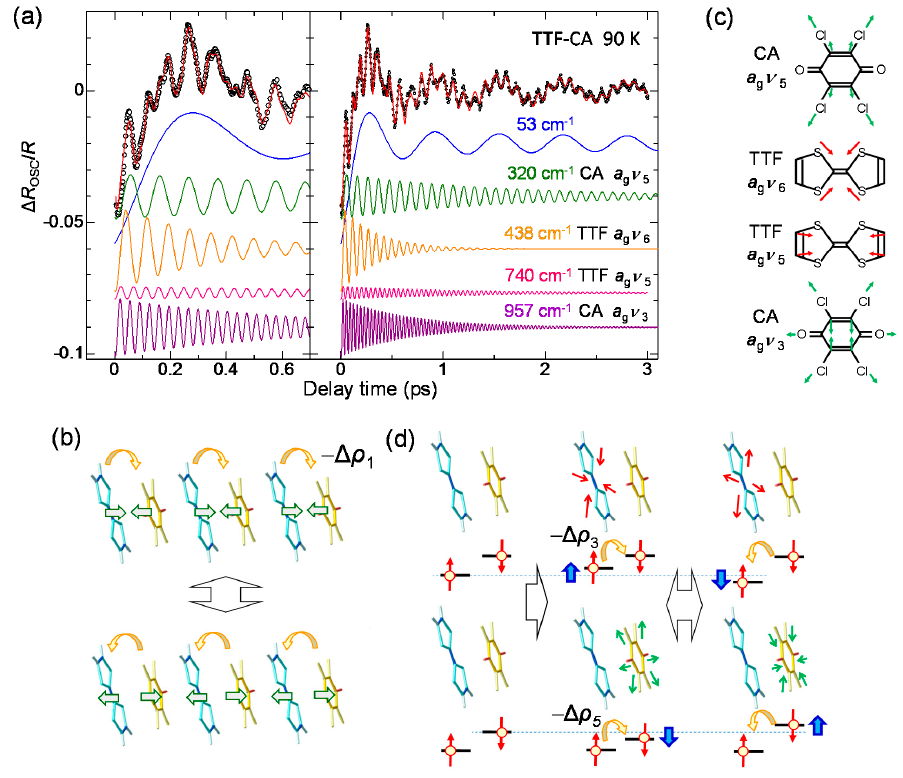
Figure 14. Fitting analyses of the oscillatory component obtained in optical-pump optical-reflectivity-probe spectroscopy with the time resolution of ~20 fs in the N phase of TTF-CA [30]. ( a ) Oscillatory component Δ R OSC / R (circles) which is extracted from Δ R / R (Figure 13b). The red solid line is a fitting curve, which is obtained by summing up below five oscillation components and convoluting it with the instrumental function; ( b ) The lattice mode of dimeric molecular displacements which is the origin of the 53 cm − 1 oscillation mode. Oscillation of electron transfer −Δ ρ 1 indicated by yellow arrows is induced by this lattice mode; ( c ) Intramolecular a g modes which are origins of high-frequency oscillatory components; ( d ) Schematic of the electron-intramolecular vibration (EIMV) coupling. Intramolecular a g modes induce electron transfers −Δ ρ 3 and −Δ ρ 5 indicated by yellow arrows.